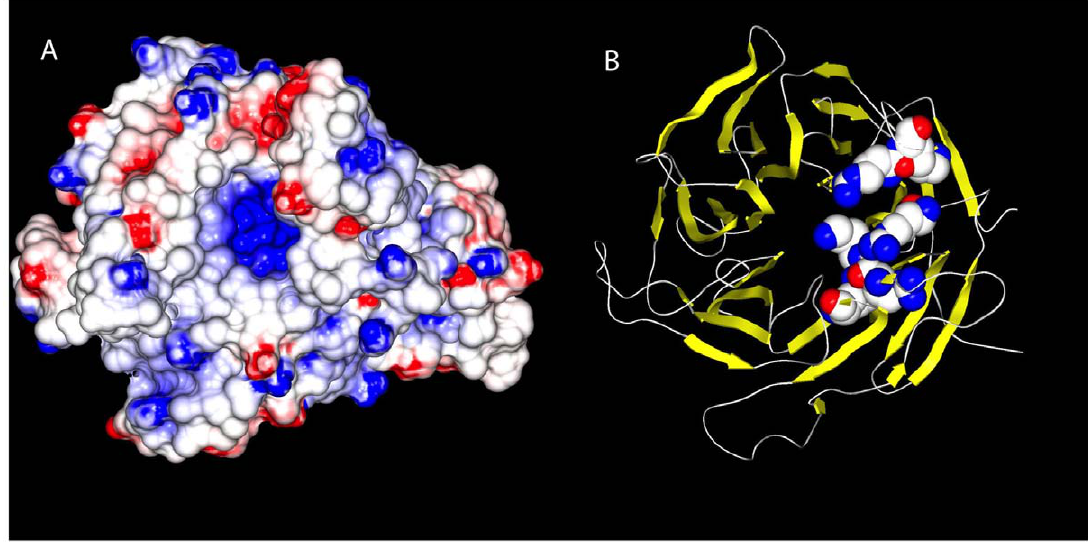
Figure 1. LRRK2 C-terminus forms distinct beta-propeller configuration. Molecular surface of the homology model of the WD40 domain of LRRK2 (left) using the structure of the BUB3 mitotic checkpoint protein (PDB code 1yfq) as a template. The coloring of the surface is determined by the electrostatic potential at each point on the surface (red=acidic, white=neutral and blue=basic). The prominent basic cleft shown at the center of the molecule was consistently present in other models of the WD40 domain of LRRK2 based on other templates. The basic character of this cleft was due to a set of basic residues that were consistently placed in each of the models we examined (K2367, R2413, K2415, R2456, R2477 and K2478). A ribbon diagram of the same model is shown at the right, highlighting these residues in sphere representation. These residues were consistently clustered together in all of the models examined. Similar modeling of LRRK1 C-terminus failed, highlighting previously suggested divergence between LRRK1 and LRRK2 in this